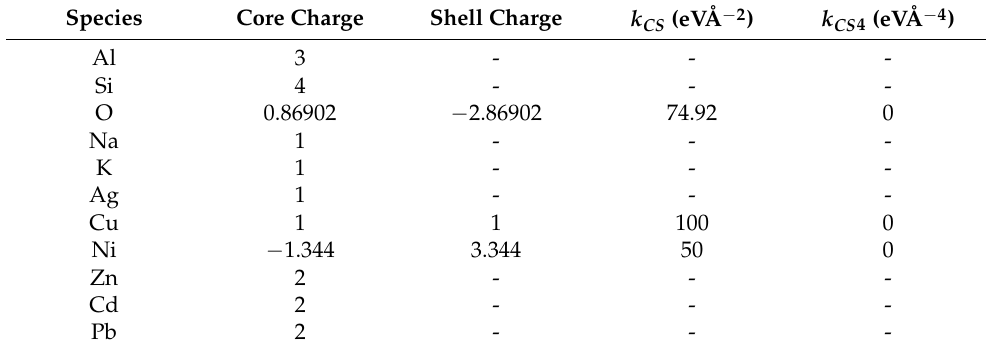
Table 5. Parameters of the core–shell harmonic potentials used in this